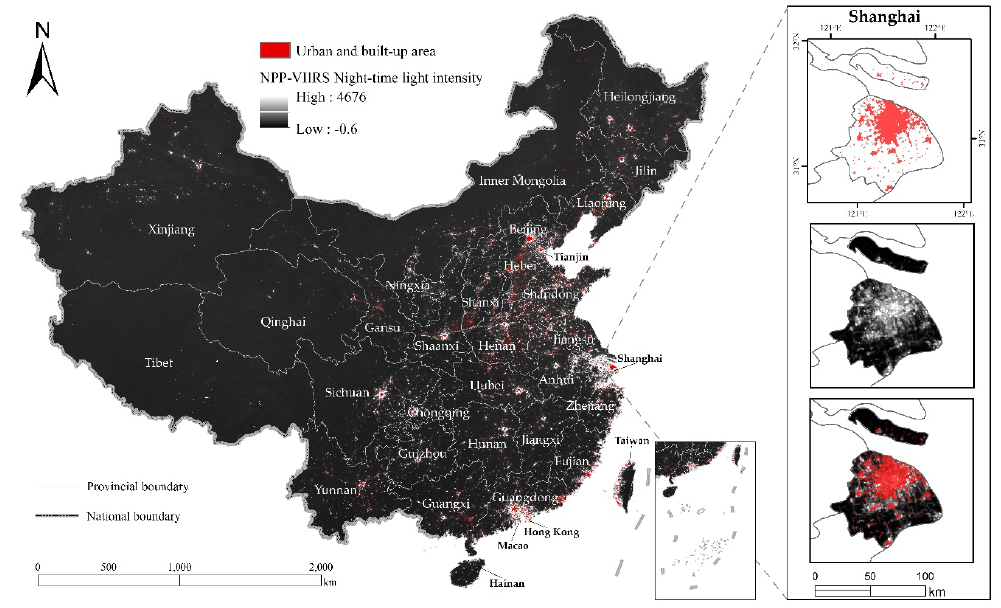
Figure 1. The Suomi National Polar-Orbiting Partnership–Visible Infrared Imaging Radiometer (NPP- VIIRS) imagery night-time light from December 2013 and MODIS land cover type yearly